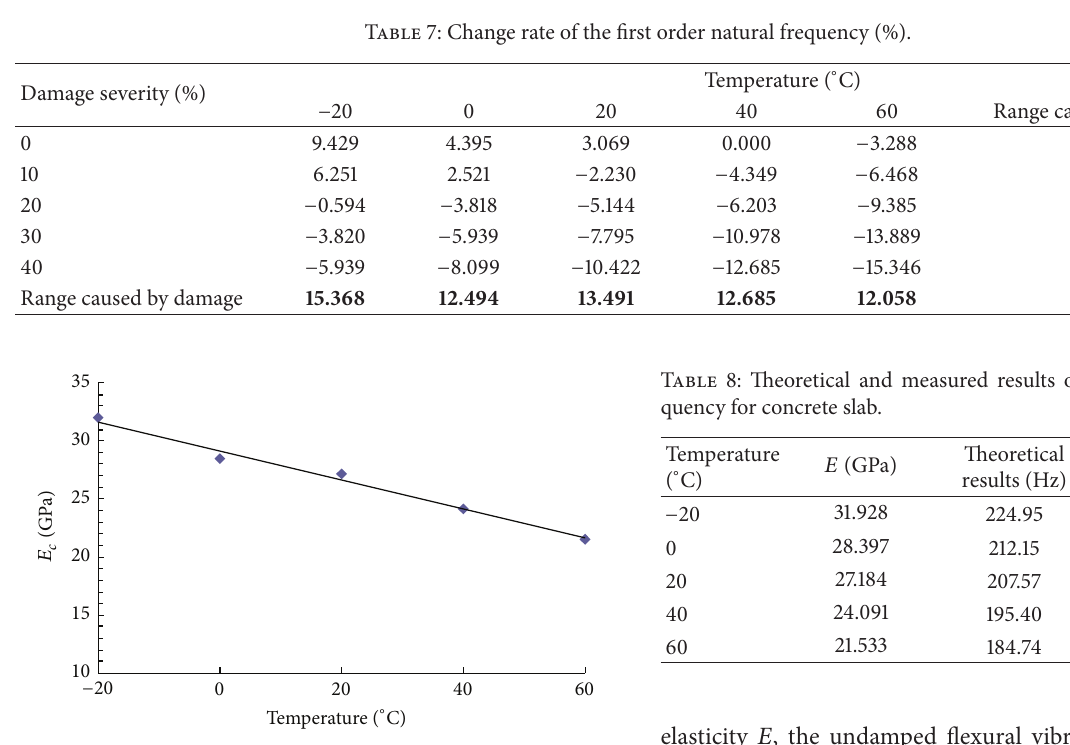
Figure 10: Temperature effect on modulus of elasticity.